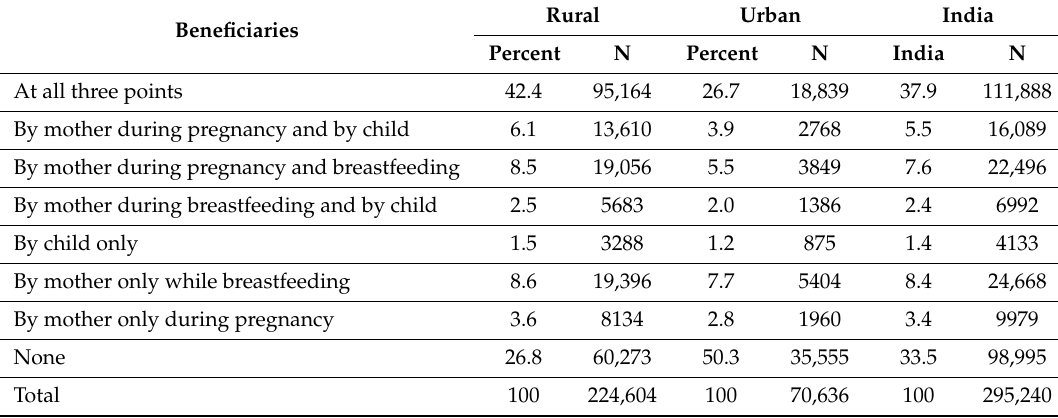
Table 3. Distribution (%) of mother–child pairs by utilization of ICDS services at di ff erent time points, India, NFHS, 2016.